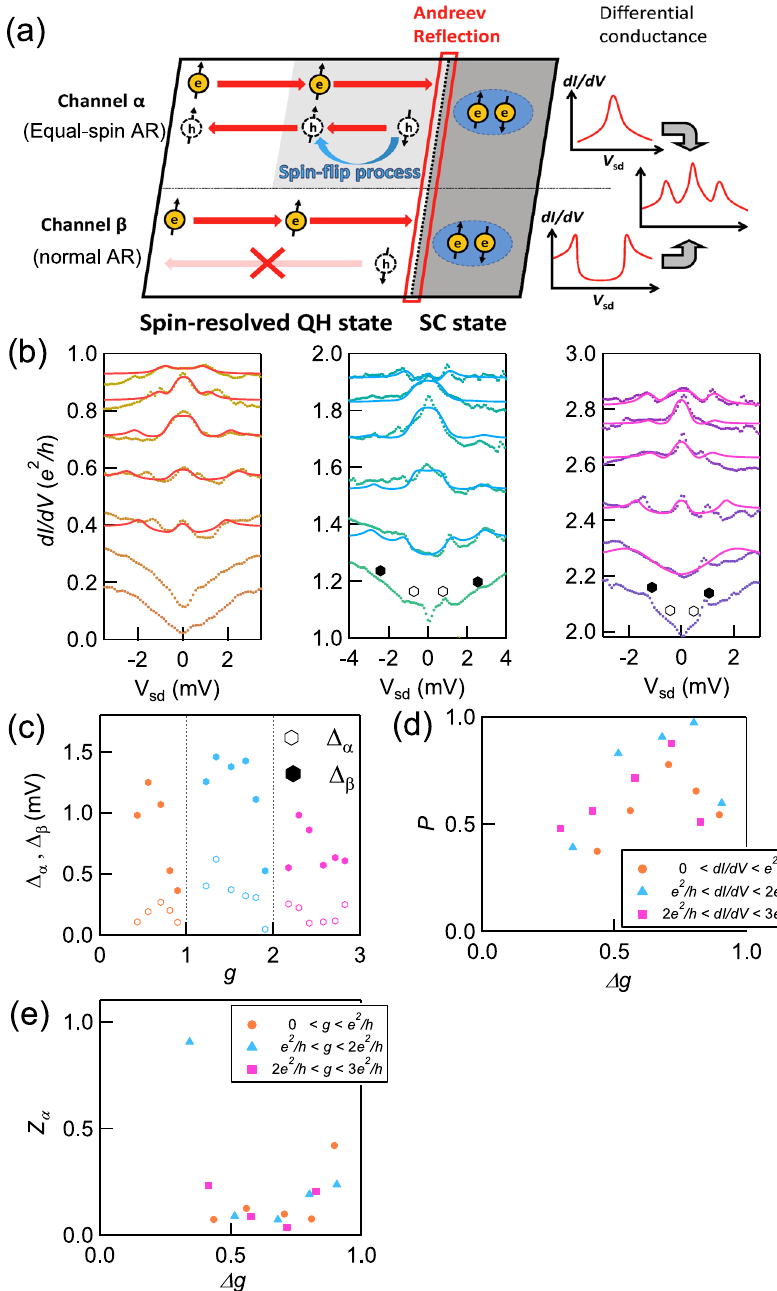
Figure 3. Numerical calculation results and the estimated parameters. ( a ) Schematic of AR in the channel α and β . AR in channel α is intermediated by the spin-flip process, while the reflection in the channel β is not. ( b ) Measured dI / dV vs. V sd at 4.0 T indicated with dots with fitting results shown as solid lines. The open and closed hexagons are the position of Δ α and Δ β without the numerical fitting. ( c ) Obtained Δ α and Δ β are shown as open and closed hexagons, respectively. Δ β has a convex upward trend in the respective plateau-transition regime. ( d ) P , indicating the relative contribution of the two channels, is shown as a function of Δ g . The orange circles, blue triangles and purple squares are P calculated from the analysis of the left, center, and right panels. ( e ) Z α is shown as a function of Δ g . The position where Z α has the minimum is the same as the P